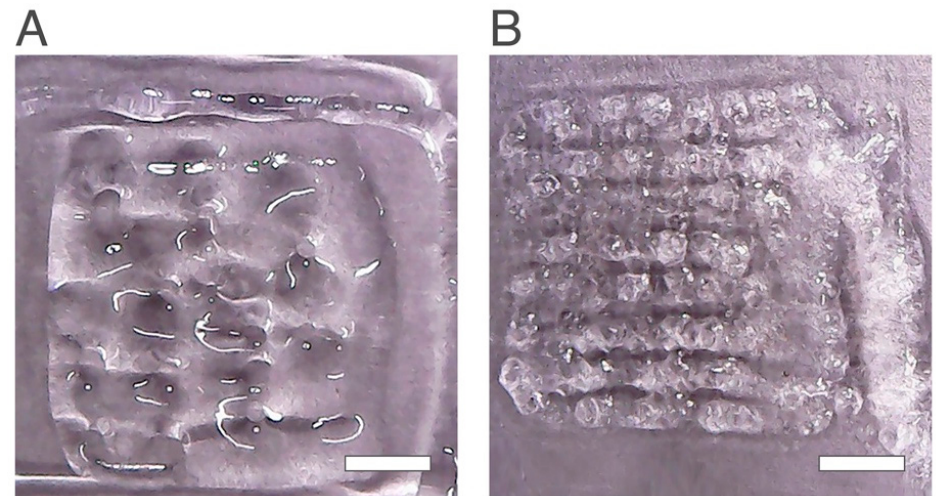
Figure 1. Scaffolds obtained using the same printing conditions and different chitosan percentages. ( A ) Chi 2.0 wt% and ( B ) Chi 2.5 wt%. The scale bar measures 5 mm.